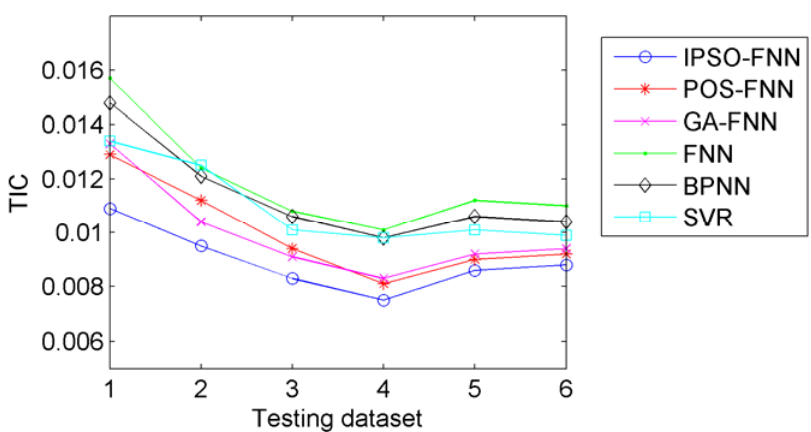
Figure 7. Comparison of Theil’s inequality coefficient.